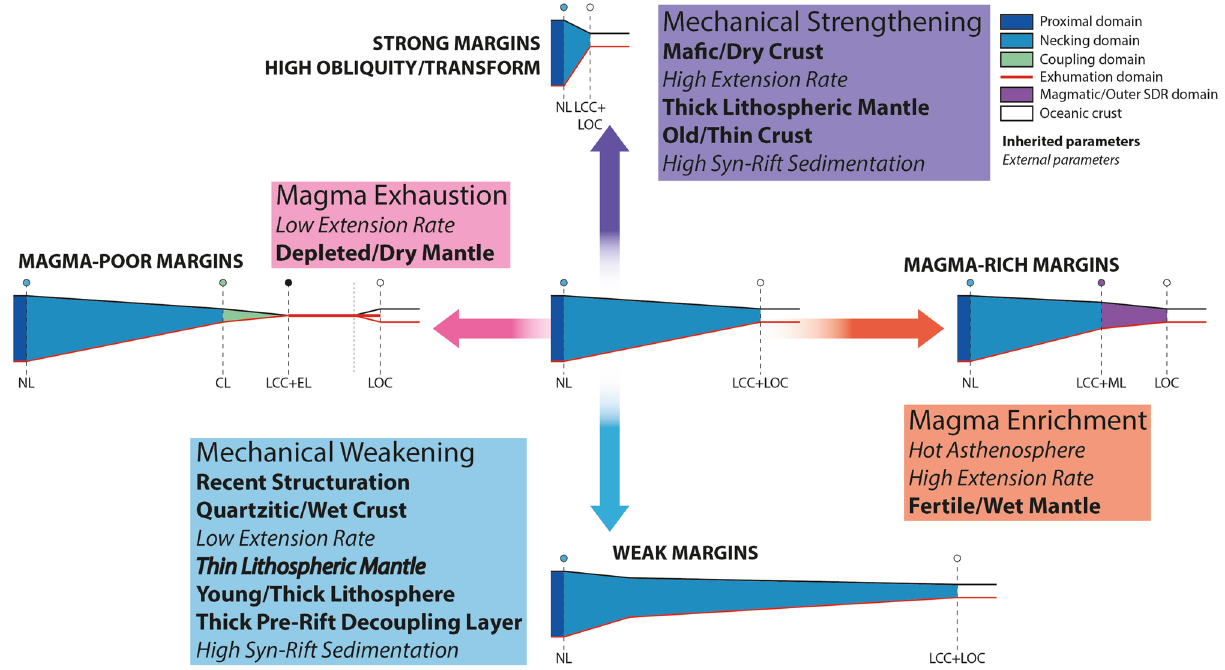
Figure 7. Forcing parameters and their influence on Rifting and Breakup axes. These parameters may be either inherited or external. When external, they can change the behavior of the margin drastically at any stage of the rifting. The obliquity is a key parameter as it seems to overprint any initial rheological/magmatic conditions. NL: Necking Line, LCC: Limit of Continental Crust, LOC: Limit of Oceanic Crust, CL: Coupling Line, EL: Exhumation Line; ML: Magmatic